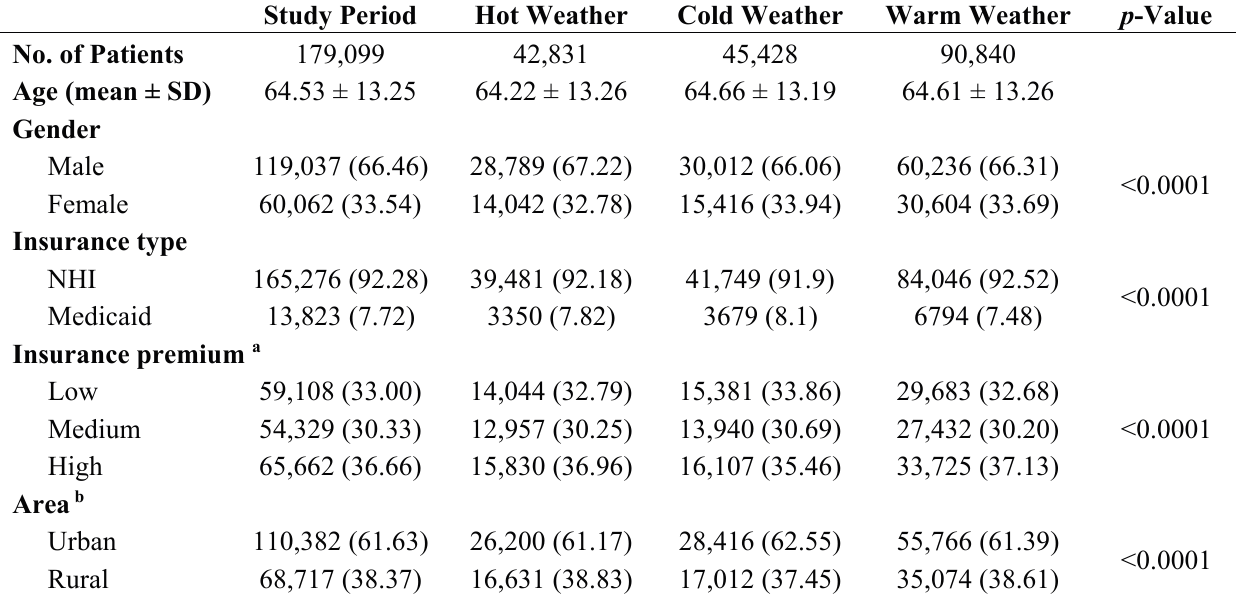
Table 1. Patients Characteristics of the acute myocardial infarction hospital admissions in South Korea during study period (1 January 2004–31 December 2012). Study Period Hot Weather Cold Weather Warm Weather p